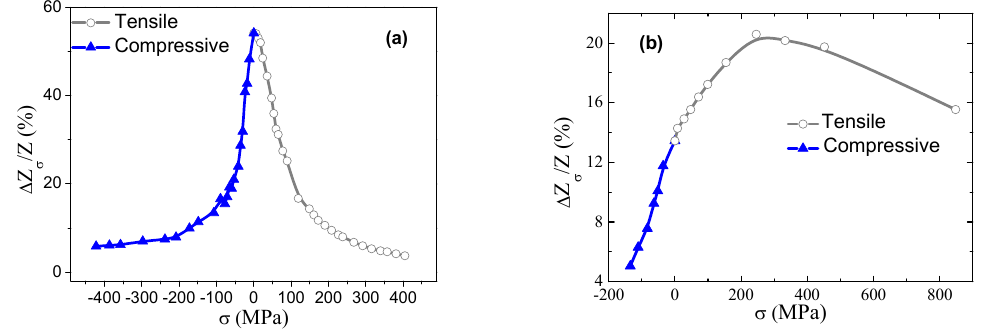
∆ Z σ ( % ) with applied mechanical stresses Z ∆(cid:3027) (cid:3345) (%) with applied mechanical (cid:3027)